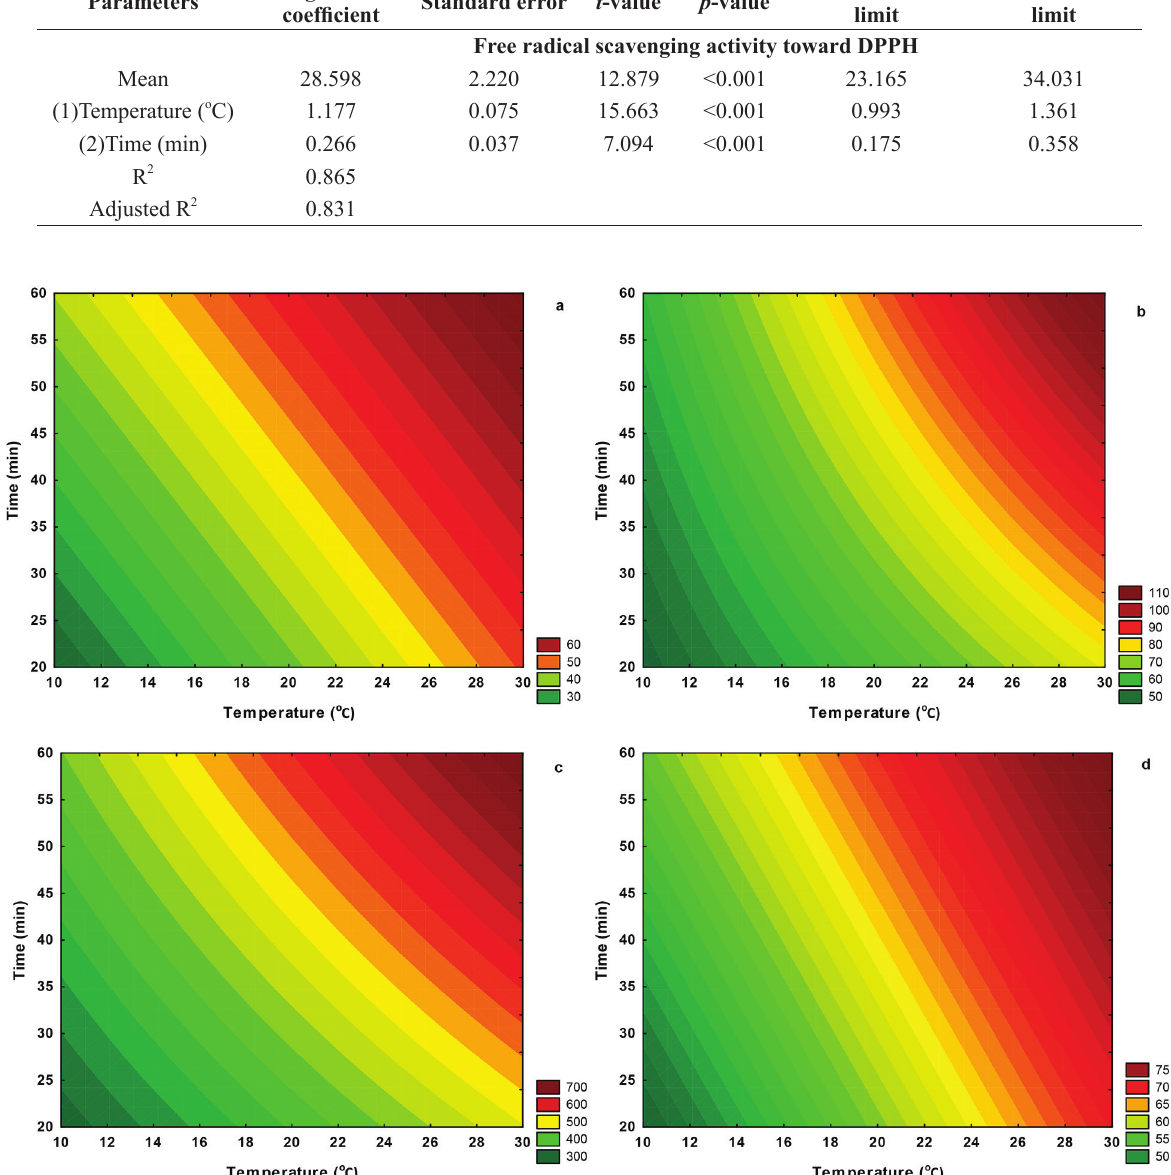
Figure 1 - Contour plots to project the experimental data obtained for the extraction of total anthocyanins (a) , total flavonoids (b) , total phenolic content (c), and free radical scavenging activity (d) of Ocimum basilicum L. extracts. All data are expressed as mg/100 g. For interpretation of the references to color in this figure legend, the reader is referred to the web version of this